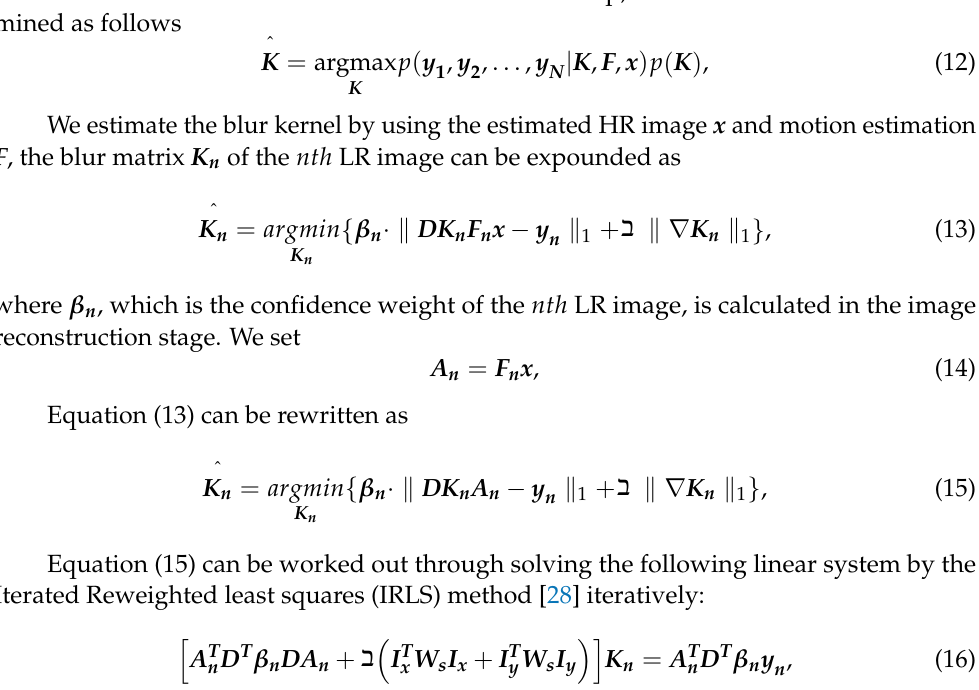
Algorithm 1. The final algorithm of multi-frame blind super-resolution.